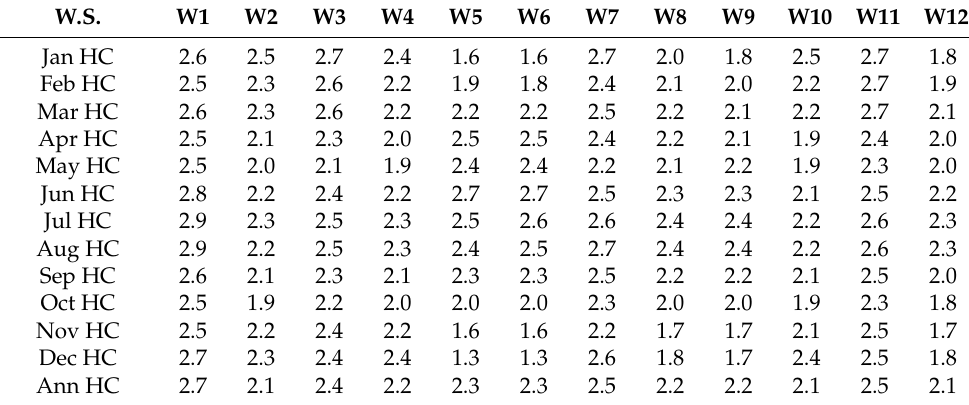
Table 6. Empirical coefficient of Hargreaves HC for each interval (Jan, Feb, Mar, etc.) multiplied by 10-3, adapted to the investigated weather stations (W1, W2, . . . ) in order to minimize the difference between the HS ET0 equation and that of PM.